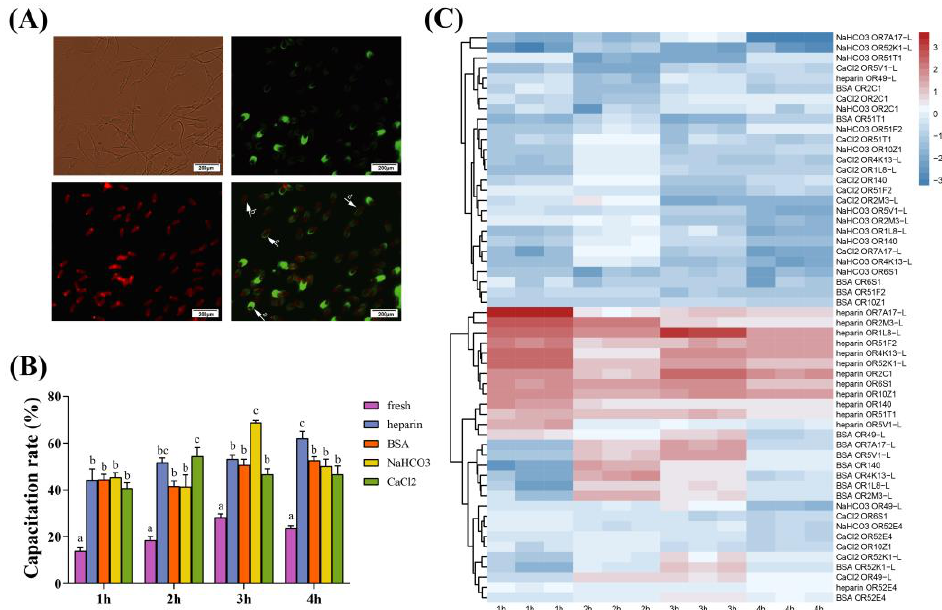
Figure 1. Sperm capacitation and mRNA expression profiling of ORs with different substances. ( A ) Assessment of the acrosomal status by a pisum sativum agglutinin (PSA)/propidium iodide (PI) staining assay. a: integral acrosome (green, PI − /PSA+), b: dead sperm (red, PI+/PSA − ), c: acrosomal reaction (green/red, PI+/PSA+), d: damaged acrosome and incomplete membrane (green/red, PI+/PSA+). The capacitation rate is equal to the sum of the C group divided by the total sperm. ( B ) Capacitation rate of sperm. ( C ) Hierarchical clustering diagram of relative mRNA expression levels of ORs in boar sperm treated with NaHCO 3 , BSA, CaCl 2 , and heparin for 1 h – 4 h. The X -axis represents the processing time, and the Y -axis represents the log10 (relative expression). The data are representative of at least three independent experiments (mean ± SEM).